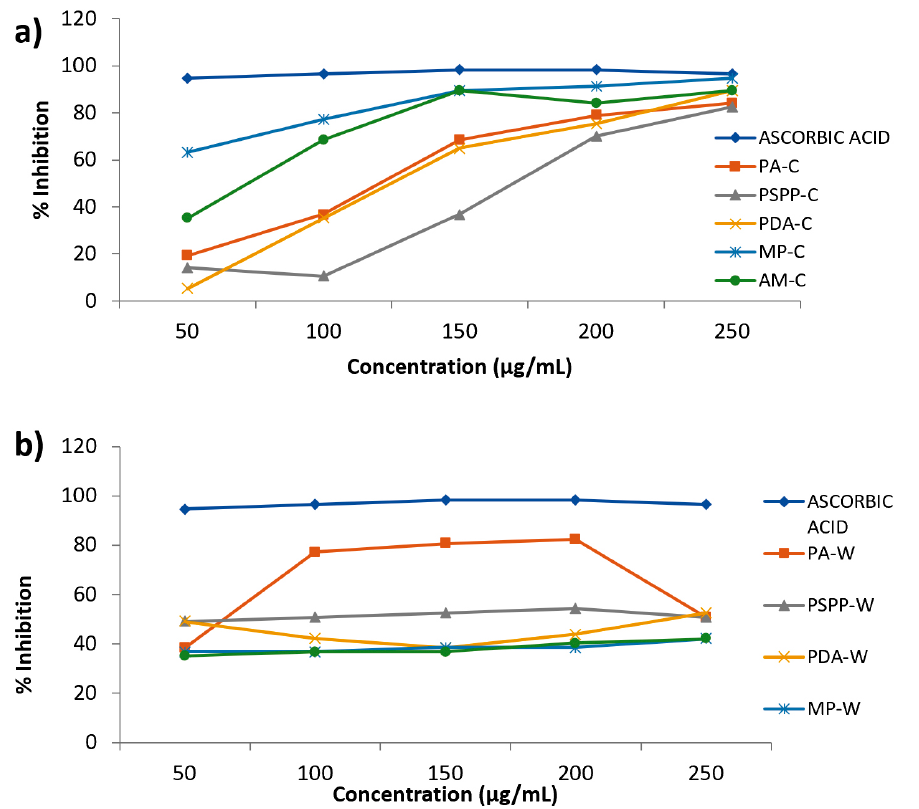
Fig. 3. Antioxidant activity by DPPH assay a) Chloroform extracts and b) Aqueous extracts PA- Phyllanthus acidus , PSPP- Piper aduncum, PDA- Pandanus amaryllifolius, MP- Macaranga peltata, AM- Acacia